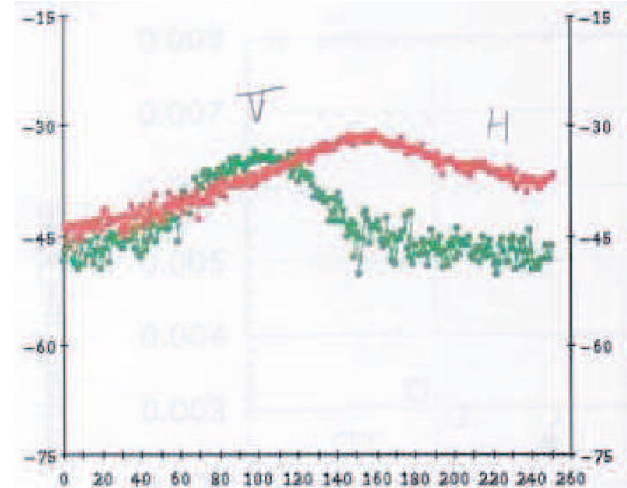
FIG. 63. (Color) Electron-density enhancement (‘‘pinch effect’’) at the beam center during the passage of an LHC bunch; the bunch head is on the left; the simulation (red curve) includes the exact nonlinear force; an analytical prediction for a linearized force is superimposed (green line); the intervals between density peaks correspond to half periods of the small-amplitude electron oscillation around the beam center; near the bunch center the density enhancement is about a factor of 50 [87]. The pinched electron distribution should give rise to a large incoherent tune spread, with protons or positron in the center or tail of the bunch and near the beam axis experiencing the largest focusing force from the electrons.